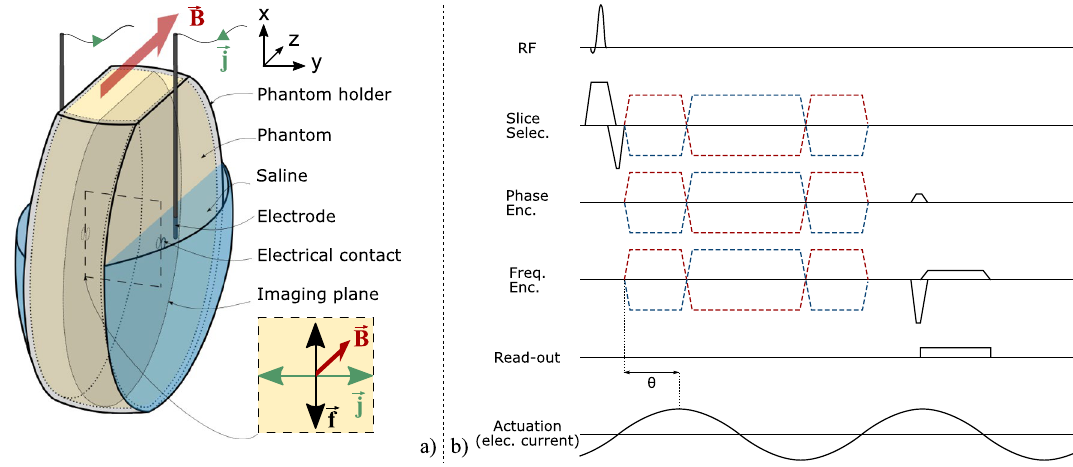
Figure 1. ( a ) Experimental setup. B is the static magnetic field along the z axis produced by the MRI system. j is the harmonic current density applied to the phantom using external electrodes plunged into the saline baths and with a main oscillating direction along the y axis. f is the Lorentz force produced within the phantom from the combination of B and j , and with a main oscillating direction along the x axis. For clarity, the main directions of j and f are represented and zoomed in the dashed cross-section. In the first experiment, electrical currents of 60 Hz and 90 Hz frequencies and of 137.5 mA peak-to-peak intensity were used. Phantom A was homogeneous and doped with NaCl to be electrically conductive. See Table 1 for phantom contents and Fig. 5 for details of the second experiment. ( b ) MRE pulse sequence diagram. MEGs of opposite polarities are indicated by the red and blue dashed lines. θ represents the phase offset between actuation and MEGs. MEGs along different directions (slice selection, phase encoding, and read-out) are successively activated in separate acquisitions.